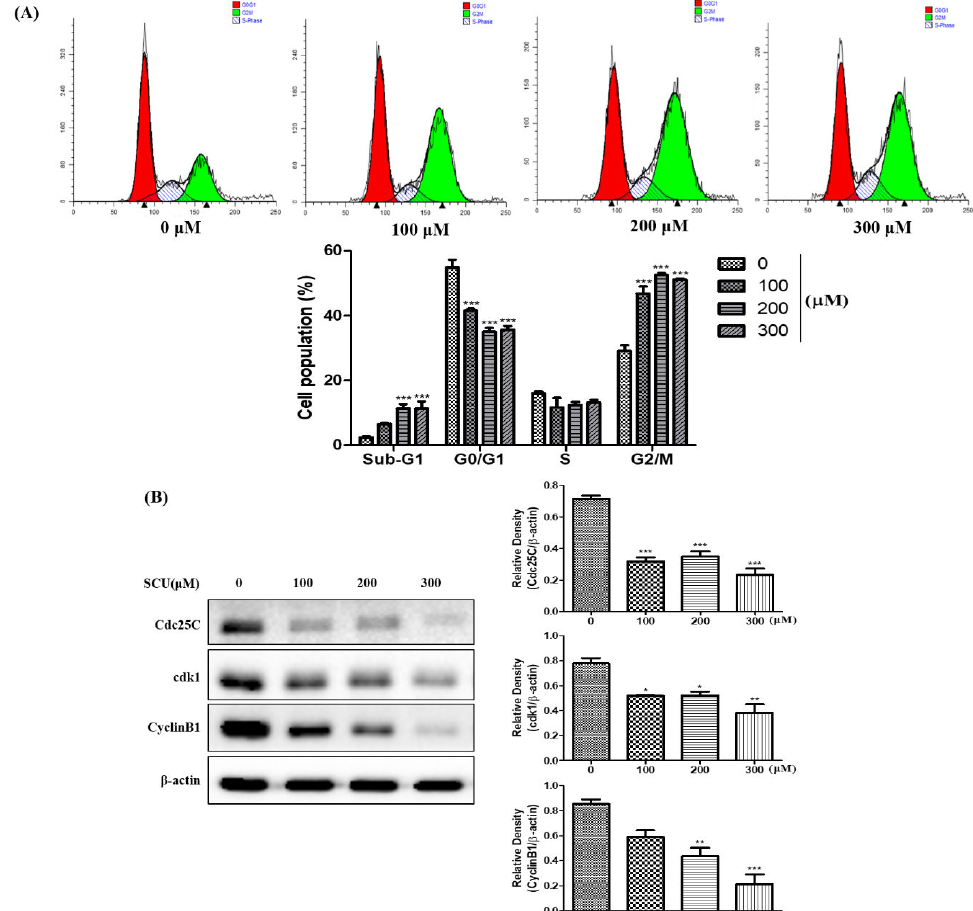
Figure 2. Scutellarein (SCU) induces G2/M cell cycle arrest of Hep3B cells. ( A ) To quantify the cell cycle phase distribution, the cells were treated with SCU at the indicated concentrations (0-, 100-, 200-, and 300- µ M) for 24 h and stained with propidium iodide (PI) followed by flow cytometry analysis (red color: G0/G1 phase; white color: S phase; green color: G2/M phase). ( B ) The cells were treated with SCU at indicated concentrations (0-, 100-, 200-, and 300- µ M) for 24 h. Total cell lysates were resolved in sodium dodecyl sulfate (SDS)-polyacrylamide gels and transferred onto polyvinylidene difluoride (PVDF) membranes. The membranes were probed with the Cdc25C, cdk1, Cyclin B1 antibodies. The proteins were visualized using electrochemiluminescence (ECL) detection system. Values are given as the mean ± standard error of the mean (SEM). * p < 0.05 vs. Hep3B cell control, ** p < 0.01 vs. Hep3B cell control, *** p < 0.001 vs. Hep3B cell